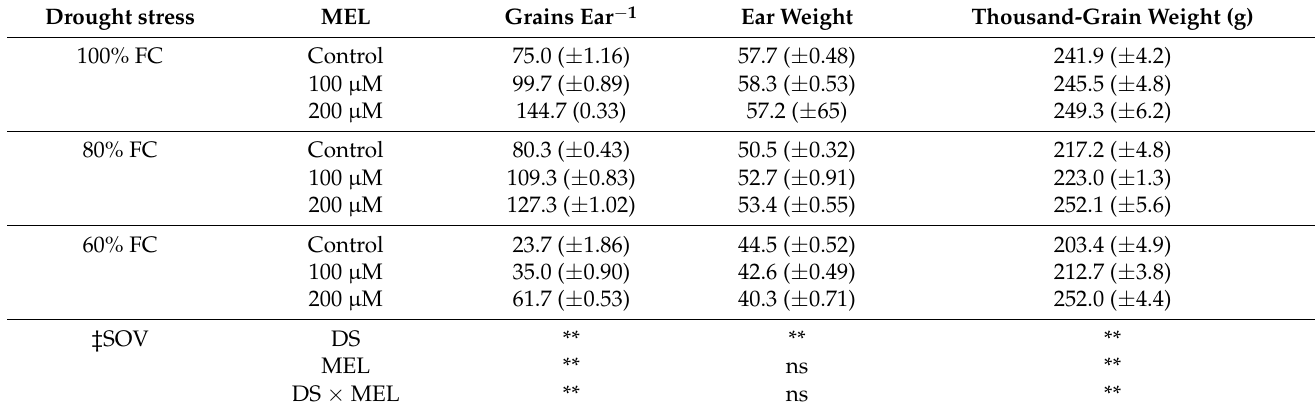
Table 3. Ear weight, grains ear − 1 , and thousand-grain weight of maize as affected by root application of melatonin under drought stress. Values in parentheses represent standard error of